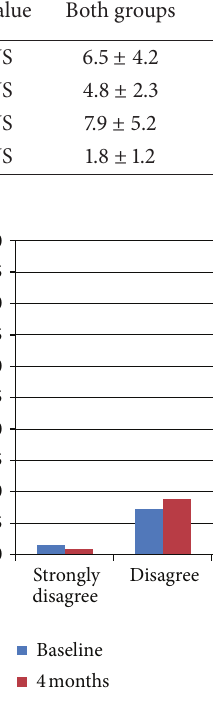
Figure 4: Frequency of response of the confidence about the accuracy of the health information found on the internet at baseline and at four